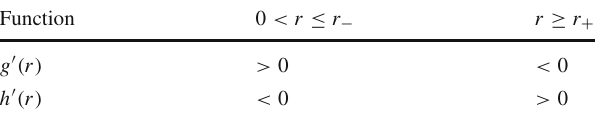
Table 2 The properties of the derivative functions g ( r ) (cid:10) and h ( r ) (cid:10) at { r | r > r + ∪ r − > r > 0 } are listed